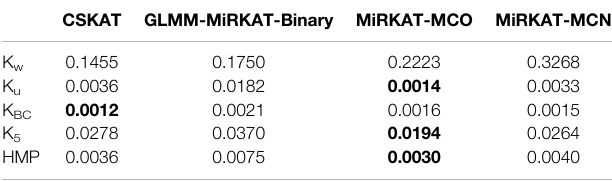
TABLE 3 | p -values of testing for the BMI-microbiome association in United Kingdom twins dataset using different methods and kernels.